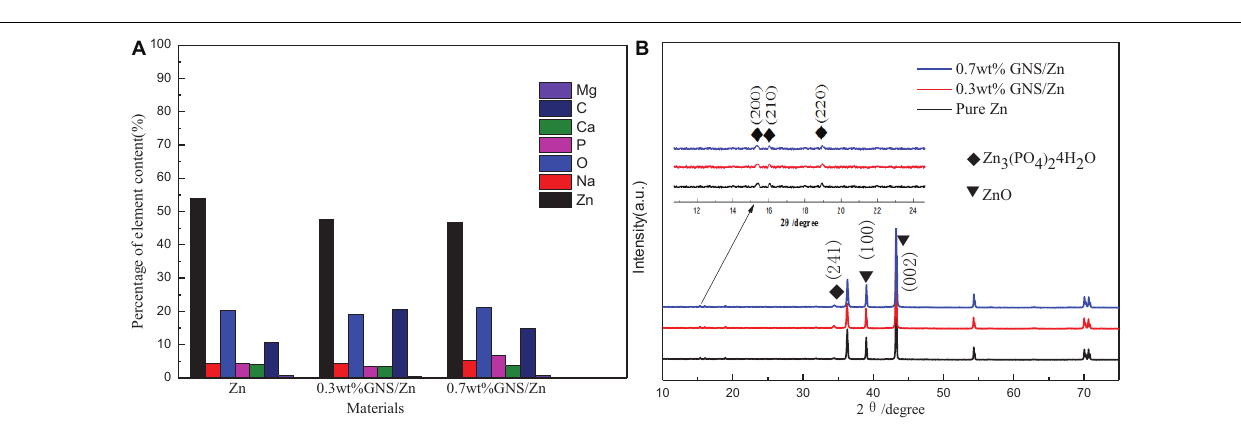
Frontiers in Bioengineering and Biotechnology |